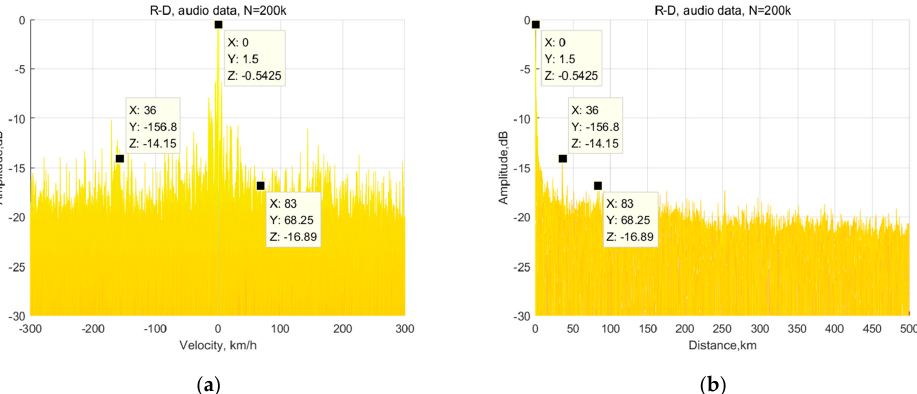
Figure 17. Integration results obtained with traditional R-D processing for the audio signal: N = 2 × 10 5 ; ( a ) Doppler dimension; ( b ) Range dimension.